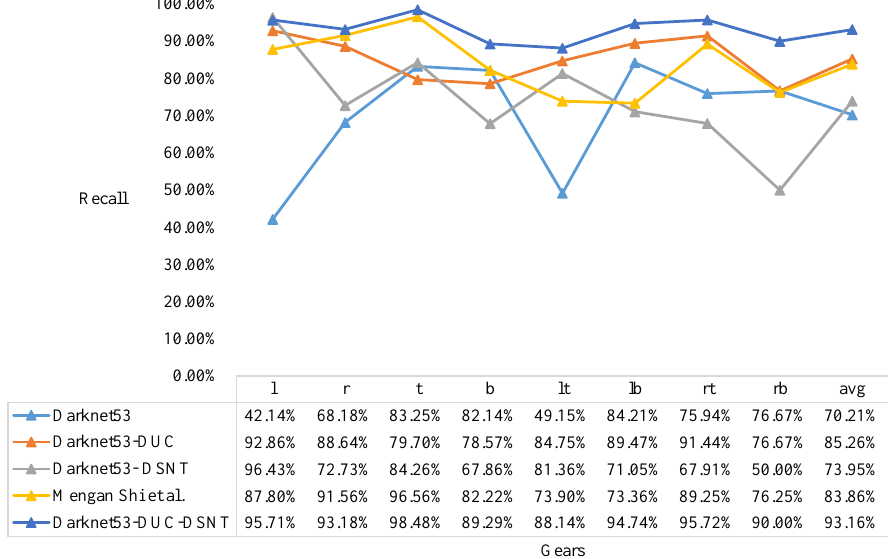
Figure 12. Recall results of knob gear classification. Comparison of Darknet53, Darknet53-DUC, Darknet53-DSNT, Mengan Shi [21], and our